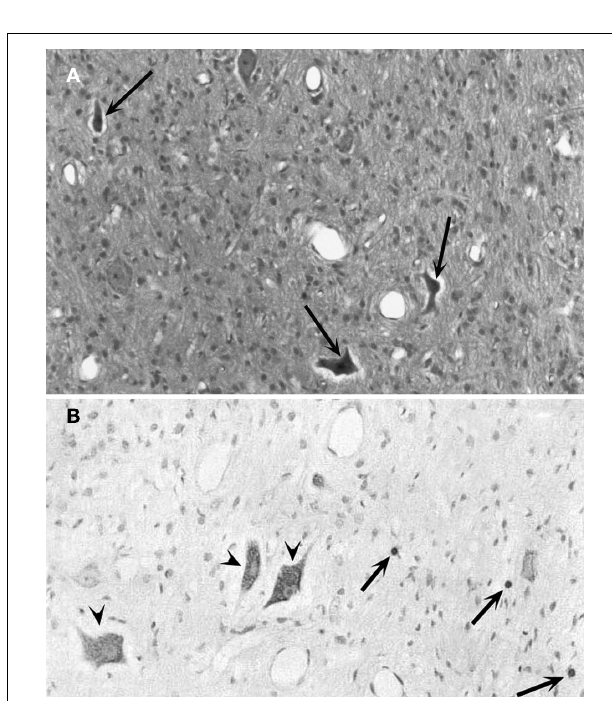
FIGURE 2 | Histological analysis. (A) View of the brain stem 3h after hypoxic–ischemic injury. Presence of large eosinophilic neurons (arrows). Hematoxylin–eosin stain. Original magnification × 200. (B) Cells with apoptotic morphology figures (arrow) in the basal ganglia of the hypoxic–ischemic group. On the left (arrowhead), damaged neurons with a negative stain forTUNEL can also be observed.TUNEL counterstained with methyl green. Original magnification ×